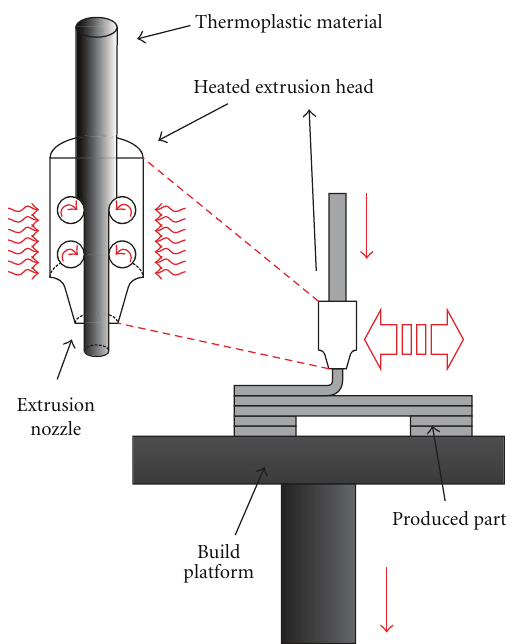
Figure 2: Fused deposition modeling process.